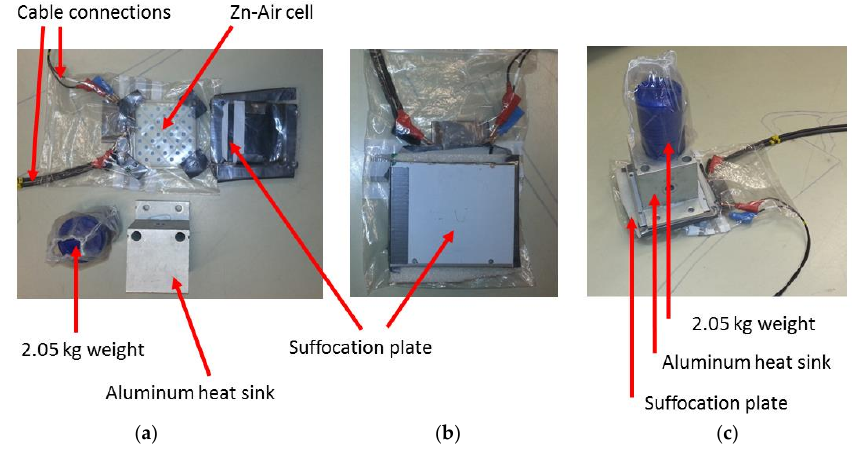
Figure 3. Suffocation setup. ( a ) All parts are separated from each other; ( b ) suffocation plate is placed over the cell; and ( c ) the aluminum heat sink and 2.05 kg weight is placed on top of the cell and suffocation plate.